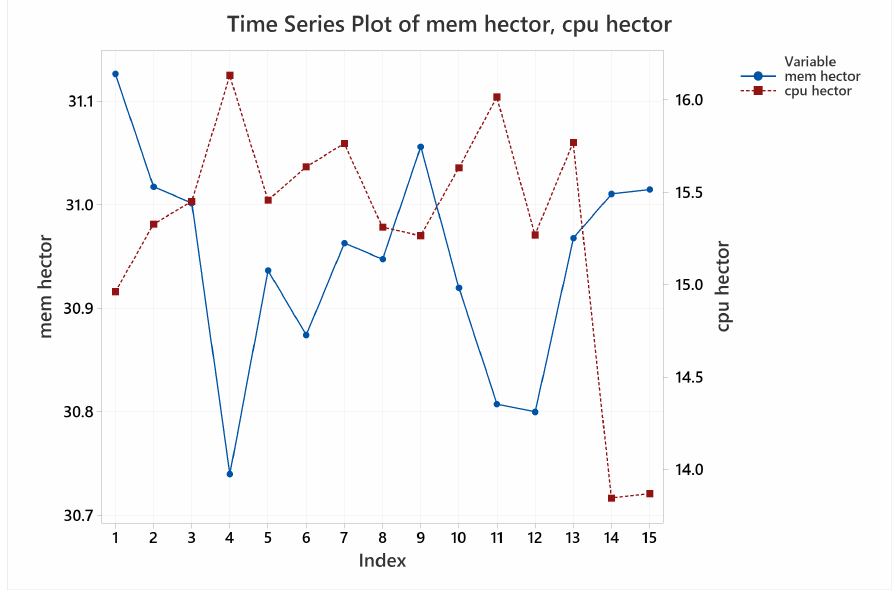
Figure 22. CPU and memory usage timeseries evolution for